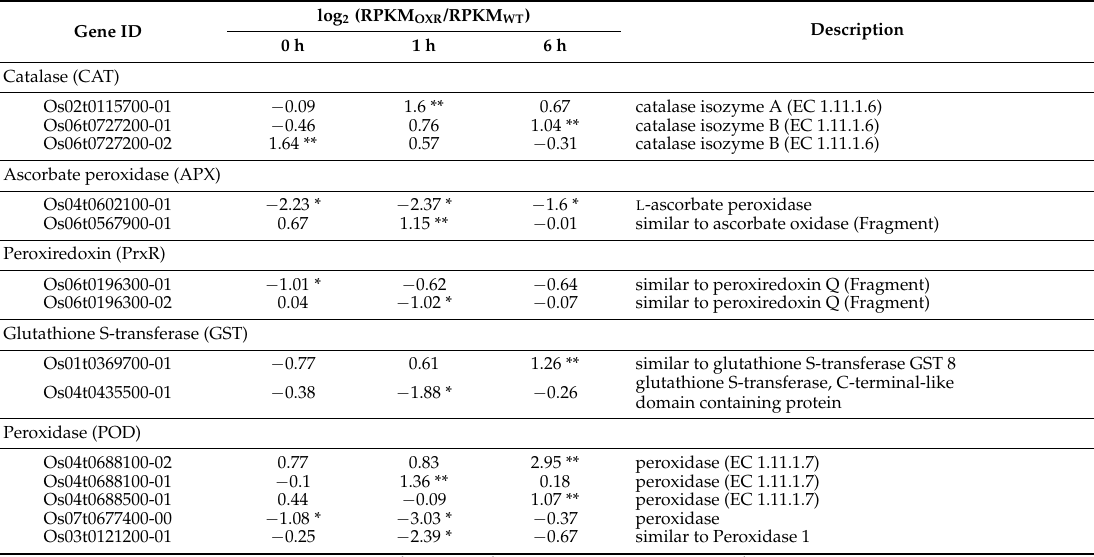
Table 4. List of DEGs related to redox regulation under salt treatment.